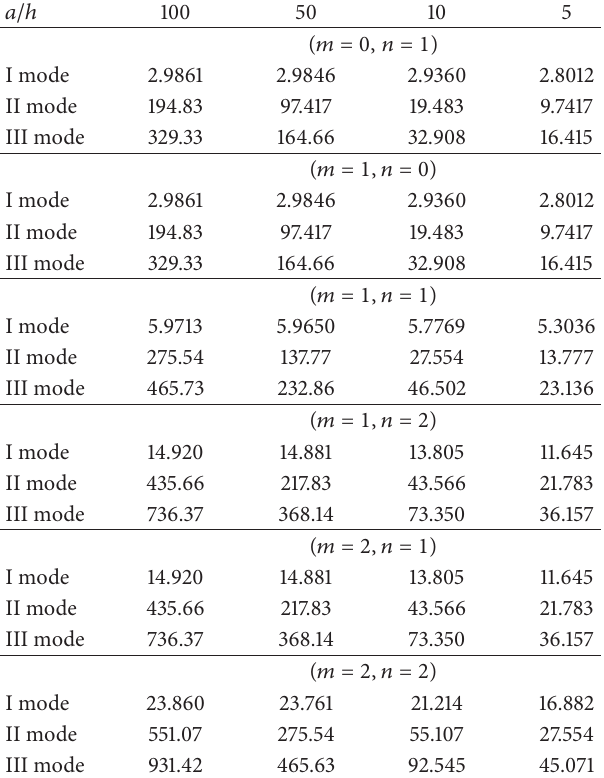
Table5:Benchmark1.Simplysupportedisotropicsquareplate.First three vibration modes in term of no-dimensional circular frequency 𝜔 = 𝜔(𝑎 2 /ℎ) √ 𝜌/𝐸 for several combinations of half-wave numbers 𝑚 and 𝑛 . 𝑀 = 1 fictitious layers and 𝑁 = 18 order of expansion for the exponential